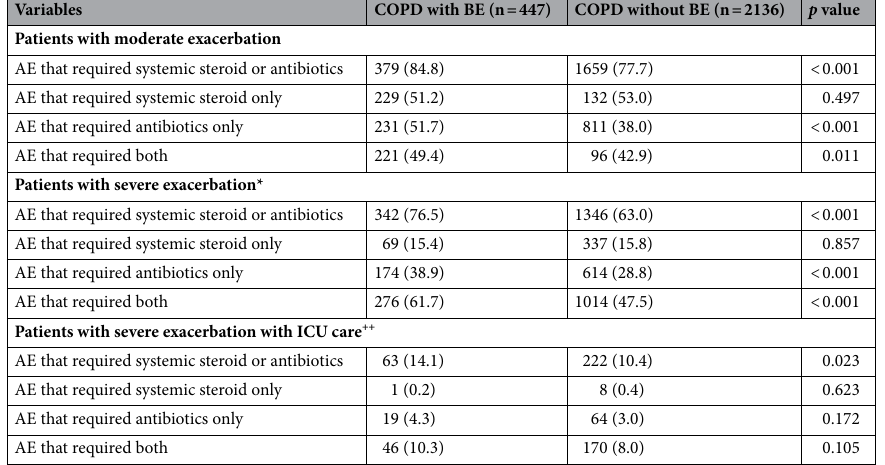
Table 2. Moderate to severe exacerbation related clinical outcomes. Data are expressed as N (%). BE bronchiectasis, AE acute exacerbation, ER emergency room, ICU intensive care unit. *Severe exacerbation included the cases which admitted from emergency room. + Moderate exacerbation was defined as outpatient department visit with a prescription of systemic steroids and/or antibiotics and severe exacerbation as emergency department visit or hospitalization with a prescription of systemic steroids and/or antibiotics. ++ Severe exacerbation with ICU meant as worsening in symptoms and requiring ICU admissions.